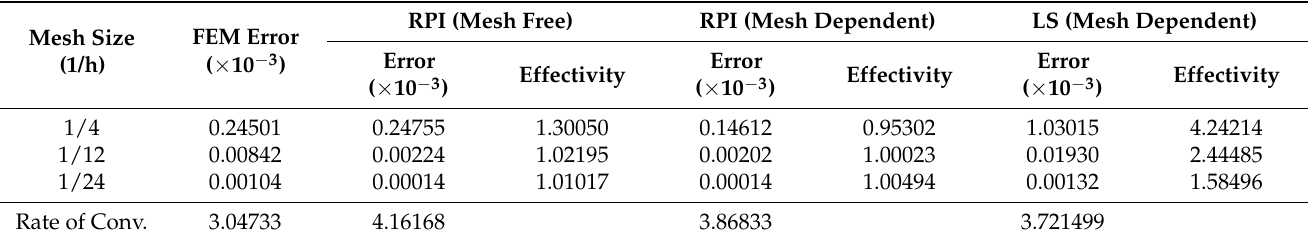
Table 2. Error convergence and global effectivity ( θ ) obtained for RPI (MQ) and least square based displacement recovery techniques (quadratic triangular, L 2 norm).